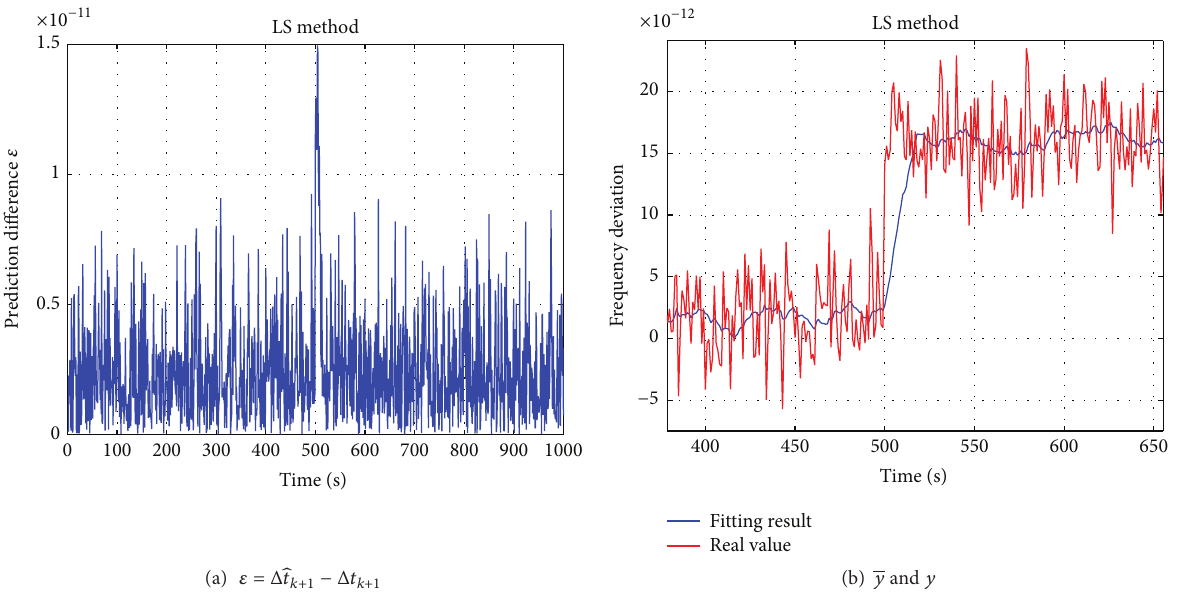
Figure 11: LS method in detecting frequency jumping.